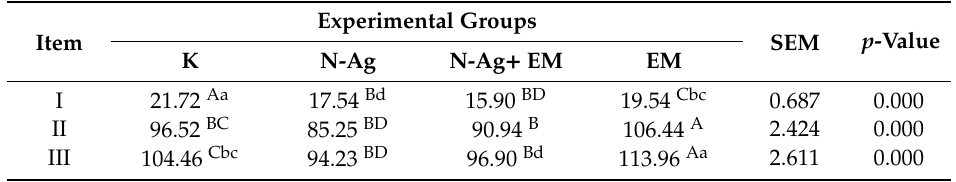
Table 3. Average body weight (g) of 10 Cornu aspersum (Müller) snails in the control and experimental groups in subsequent measurements during fattening.